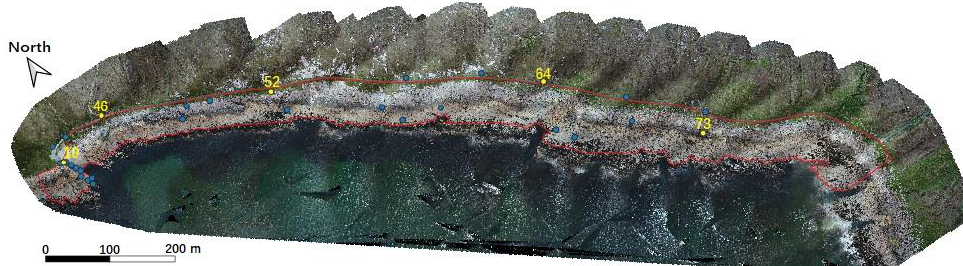
Figure 8. Distribution of GCPs. The blue dots represent the 25 GCPs included in the Pix4DMapper calculations. The yellow dots represent the 5 GCPs used to confirm the accuracy achieved by the model, and the red range represents the research area. Table 1. Error values for the 2017, 2018, and 2019 models at the positions of the 5 GCPs. ID